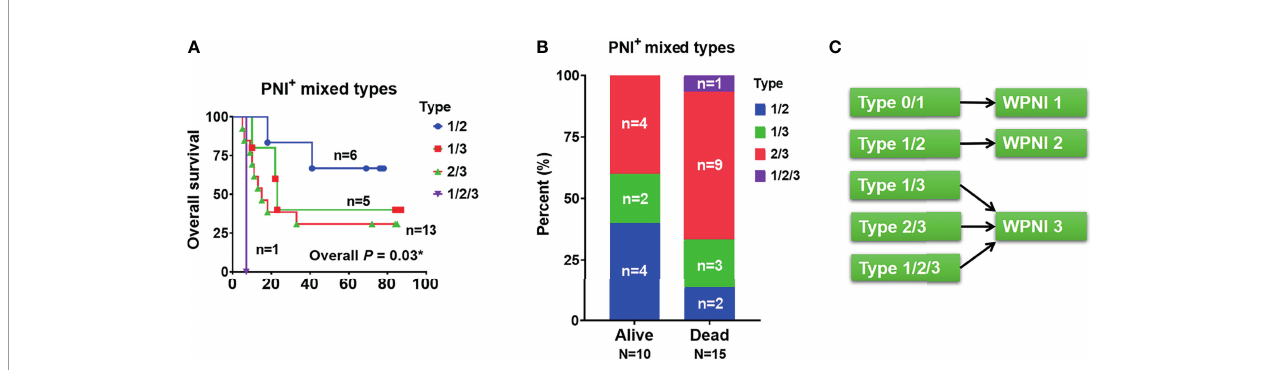
FIGURE 4 | The PNI status of OSCC patients should be subdivided into three types of WPNI. (A) The overall survival curves were drawn and compared within PNI + patients with mixed PNI types. (B) The stack graph showing the frequency distribution in PNI + patients with mixed PNI types. (C) As the highest PNI type perfectly indicated the patients ’ survival outcome, PNI type 0 or 1 was rede fi ned as WPNI 1, the mixed PNI type 1/2 was reclassi fi ed as WPNI 2, and the mixed PNI types 1/3, 2/3, and 1/2/3 were combined as WPNI 3.